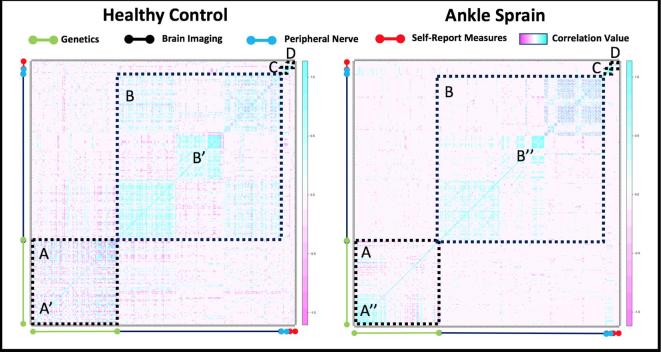
Integrated Cross Modal Analysis. Coherence/correlation maps indicating a relationship between brain or inflammatory marker or self-reported measures (healthy vs. patients). The analysis shows differences in patterns within the heatmap for genes evaluated (A), structural brain regions (B), peripheral nerve measures (C) and psychological/self-reported measures (D). A stronger relationship is indicated by the increase in (blue-purple) vs. a weaker relationship (no-color). (For interpretation of the references to color in this figure legend, the reader is referred to the web version of this article.)